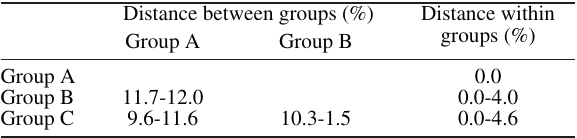
Table 2. – Uncorrected p -distances based on COI